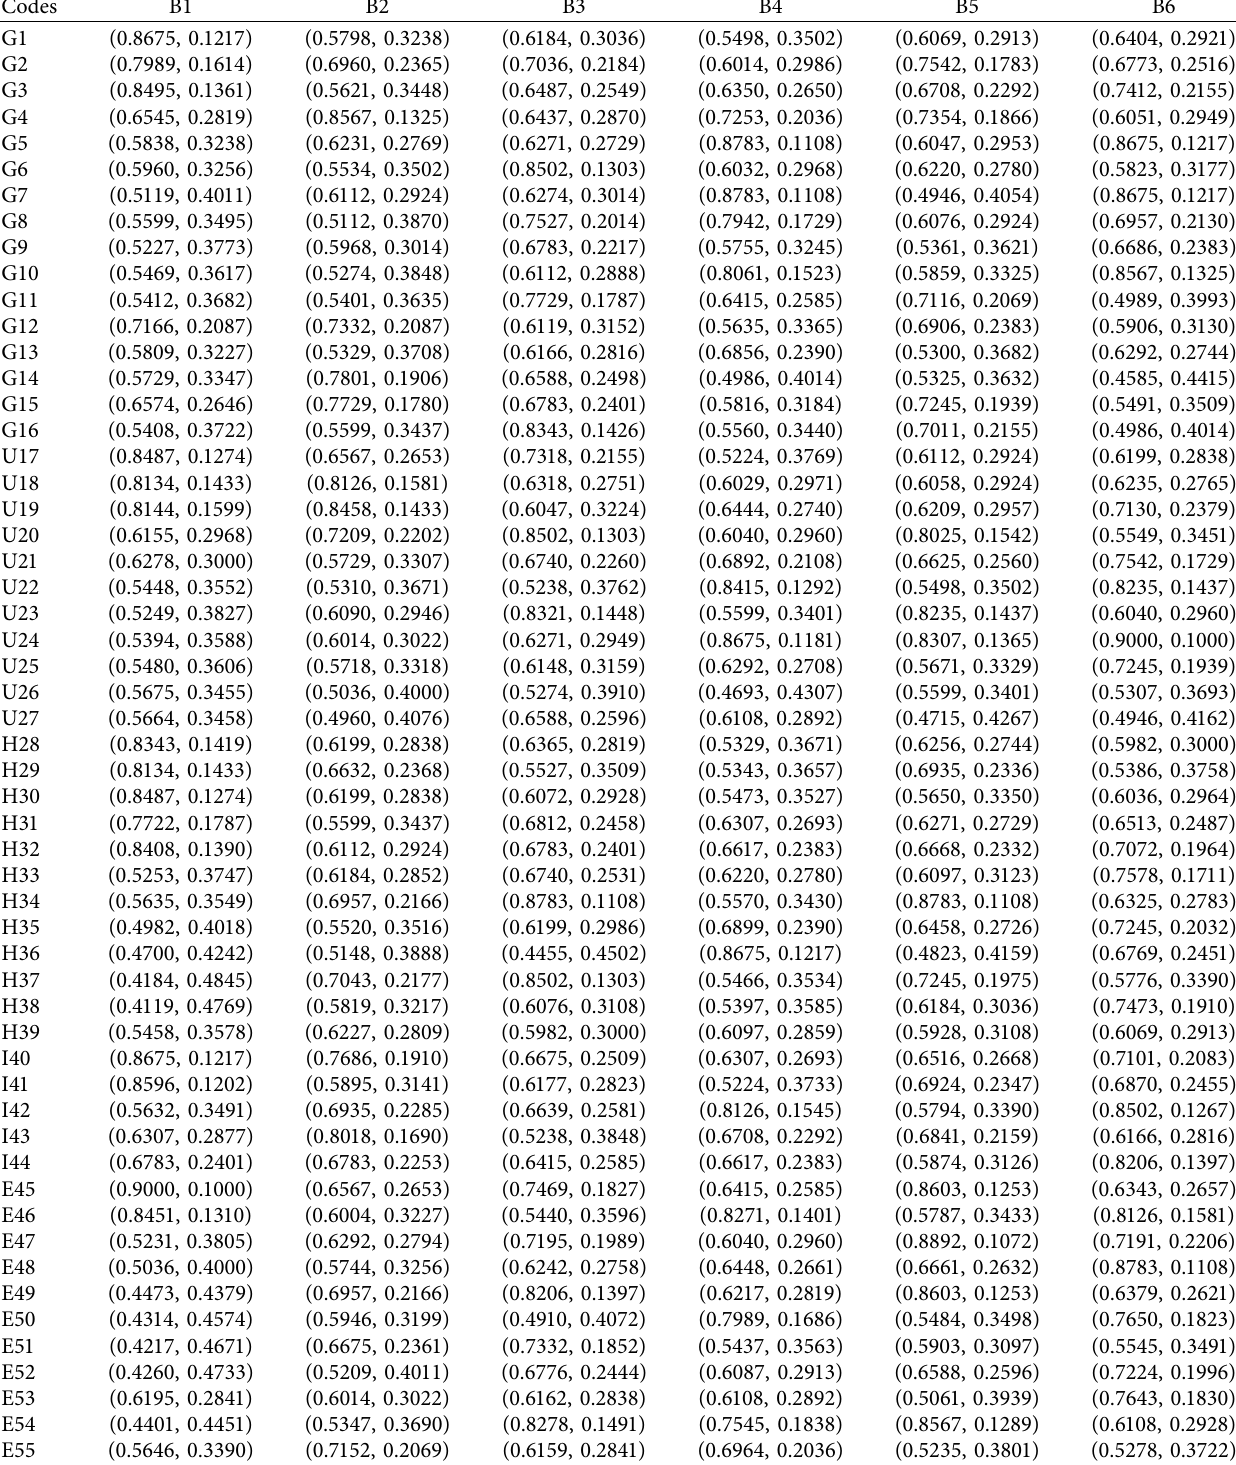
Table 5: Aggregate FF decision